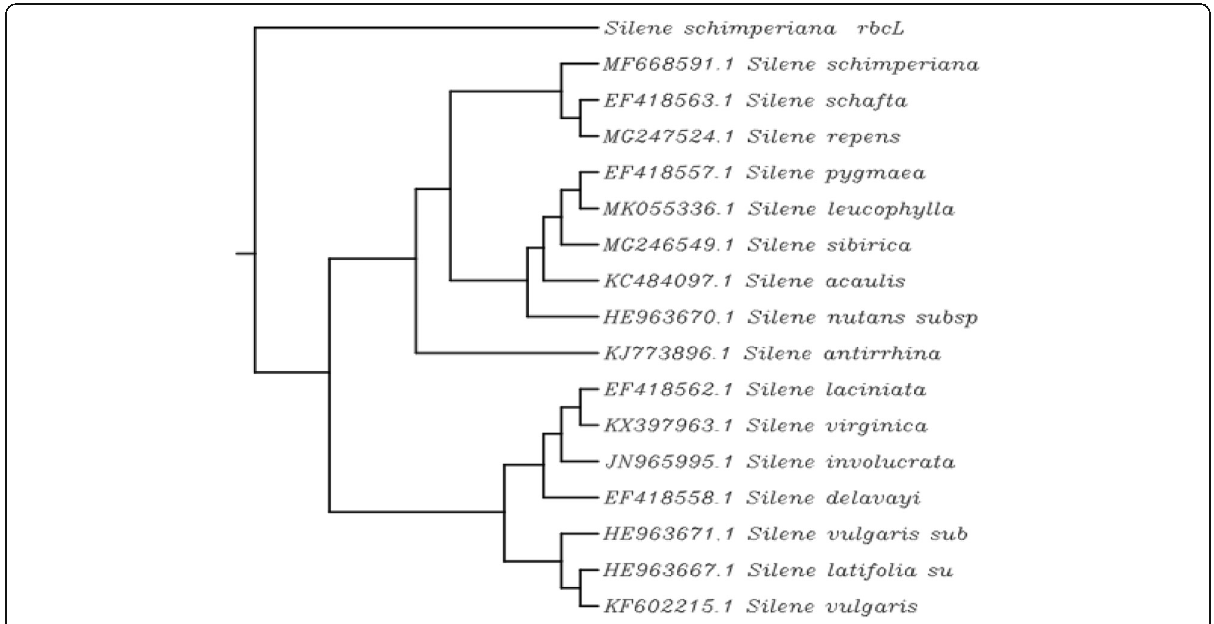
Fig. 6 Phylogenetic tree of Silene schimperiana using the cpDNA marker: 1,5-bisphosphate carboxylase/oxygenase large subunit ( rbcL